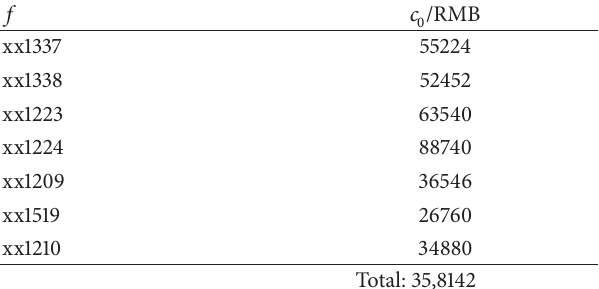
Table 1: Estimated